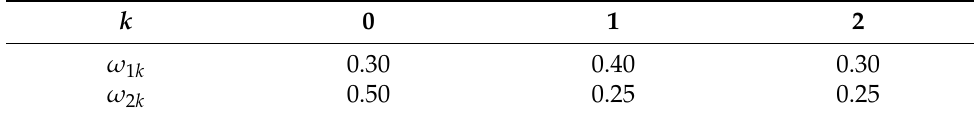
Table 1. Matrix of weights used for the numerical